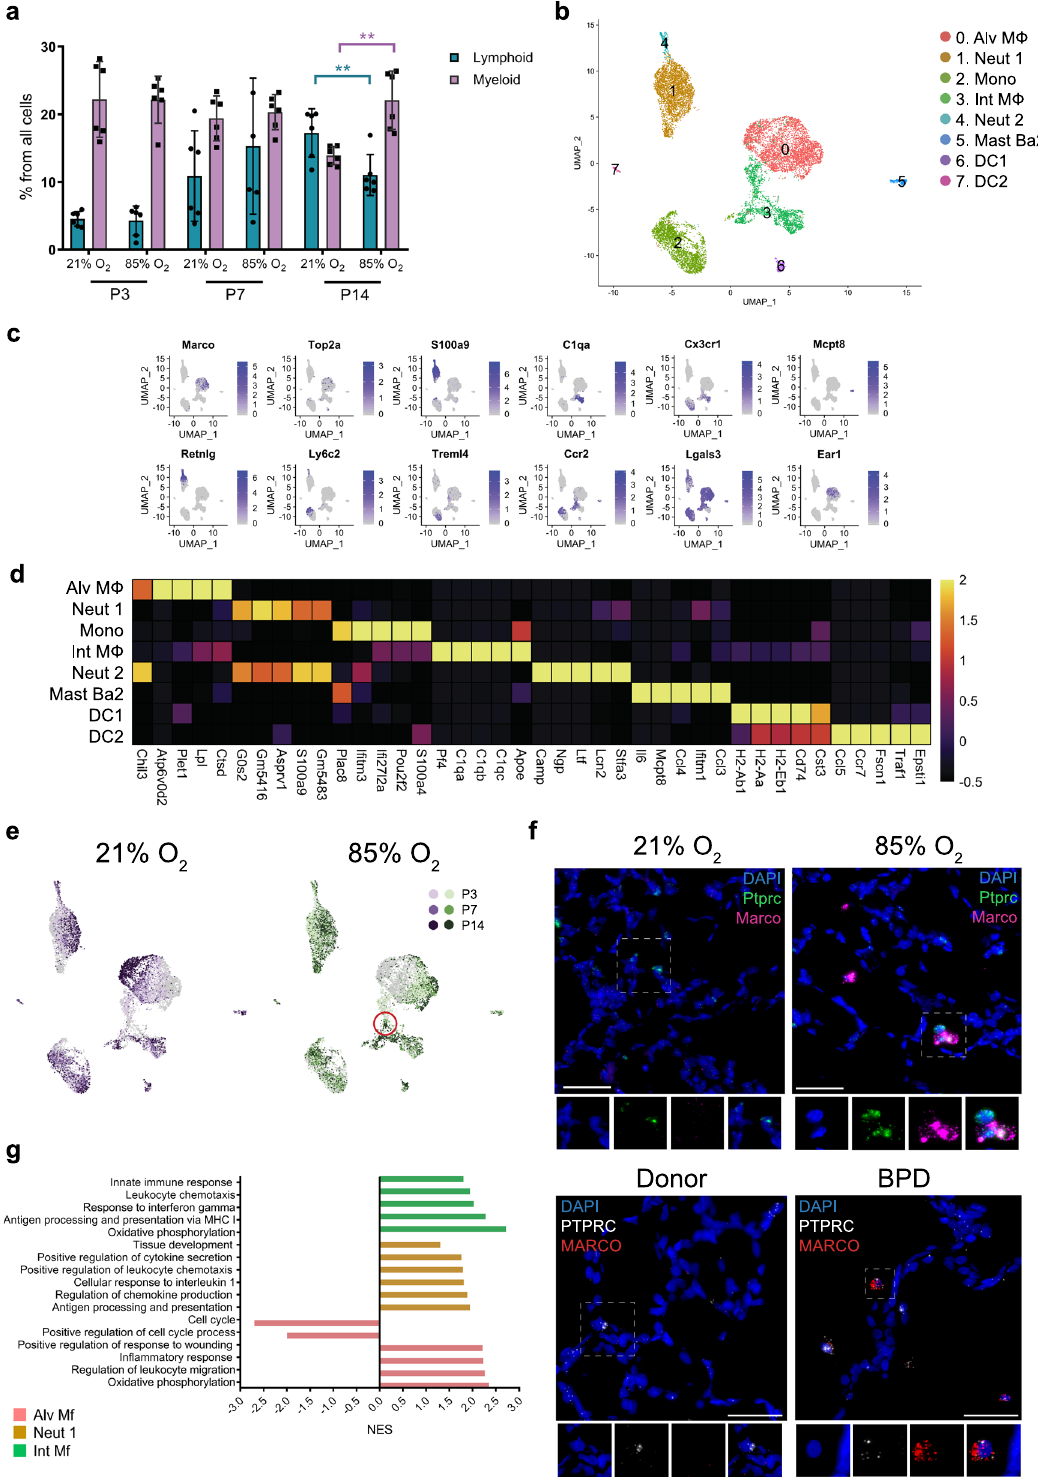
cells remaining the major immune cell population of the lung at P14. Hyperoxia alters the expression pro fi le of murine mesothelial cells . A single mesothelial cluster (Fig. 2a, b) was identi fi ed based on the expression of Msln and other known markers 35 (Fig. 8a, Supplementary Data 18). Although mesothelial cells